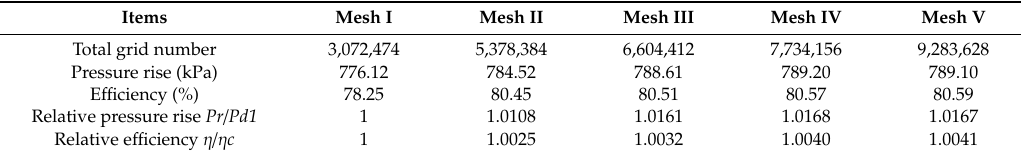
Table 2. Supercharging and e ffi ciency in relation to mesh